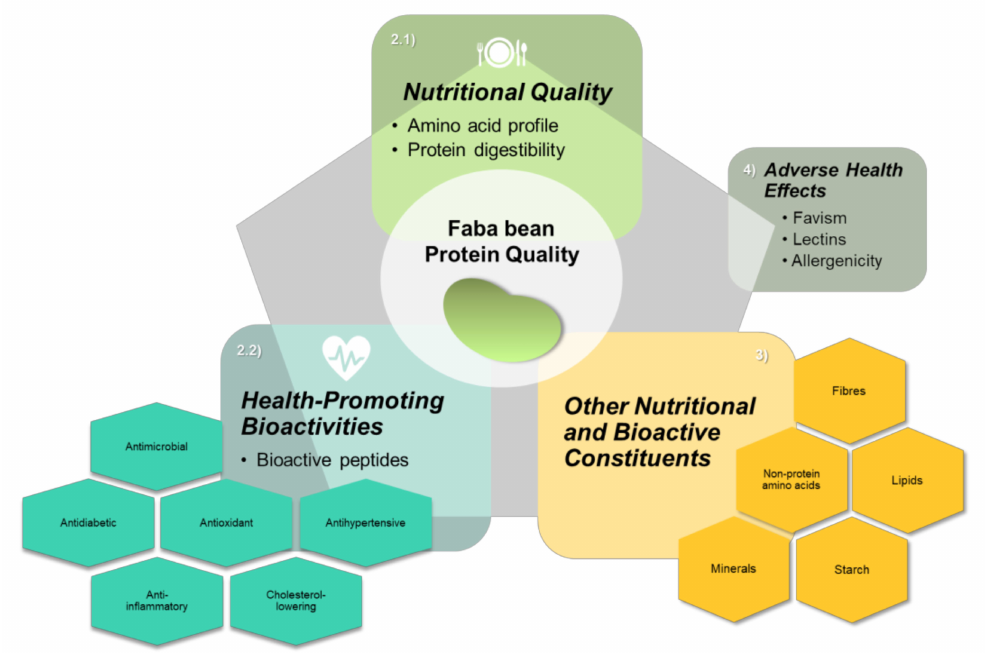
Figure 1. Faba bean protein quality is influenced by several factors, including nutritional qualities (amino acid profile and digestibility), health-promoting bioactivities, and other matrix constituents that can have beneficial (as well as adverse) nutritional and bioactive